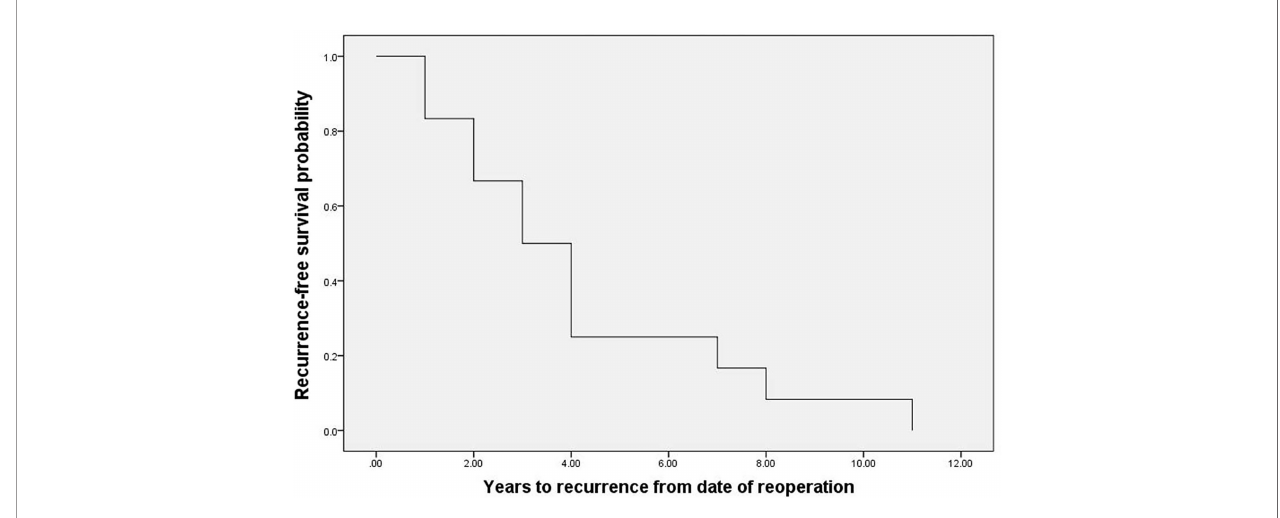
FIGURE 6 | The recurrence-free survival probability after